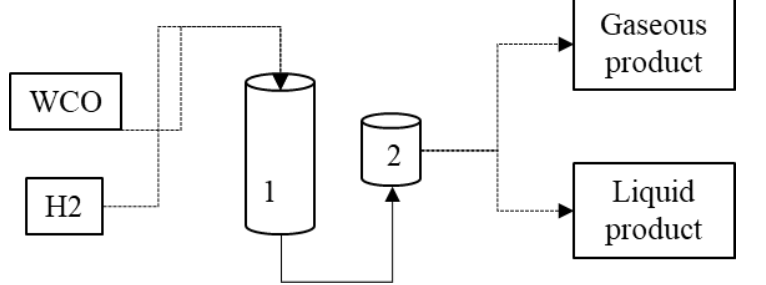
Figure 2. Representation of the hydrocracking process. (1) Reactor; (2) vacuum separation of products. (Adapted from [24].)